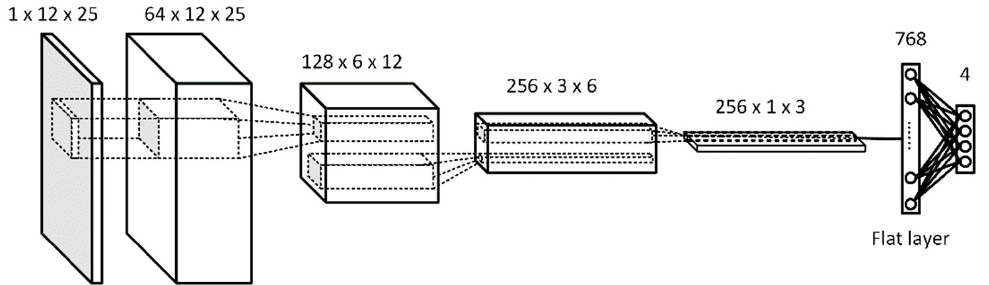
Figure 11. The base DCNN model for the classifier.